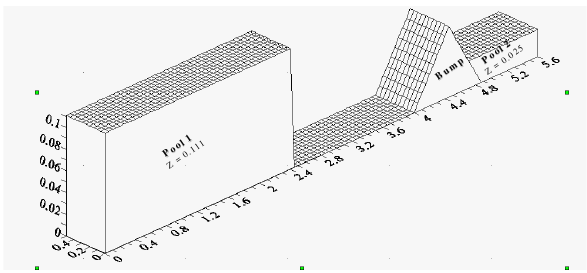
Fig. 11. Initial condition for the bump test case (Soarez et al., 2002).